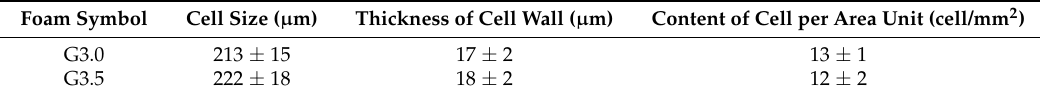
Table 8. Results of SEM micrographs